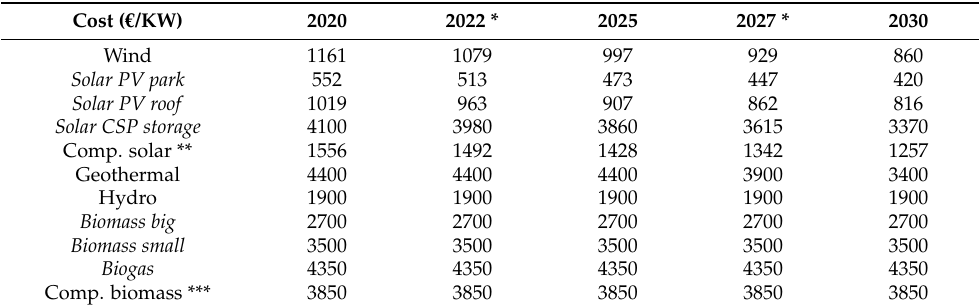
Table 1. Cost change estimates for the deployment of RES plans in Greece per type and KW of installed capacity for 2020–2030.